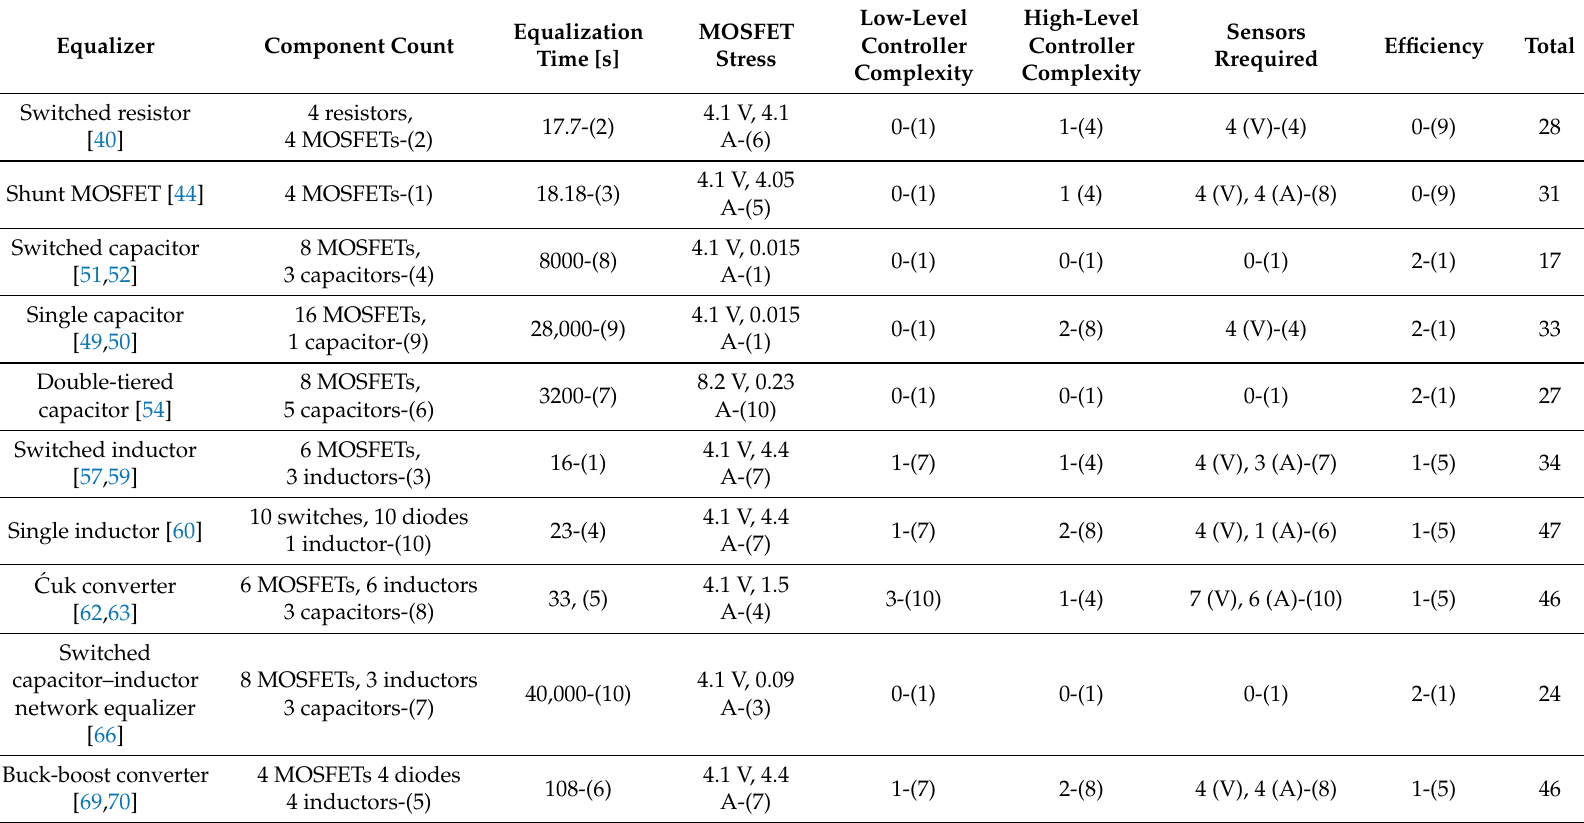
Table 6. Comparative analysis of the reviewed equalizers for a four-cell battery